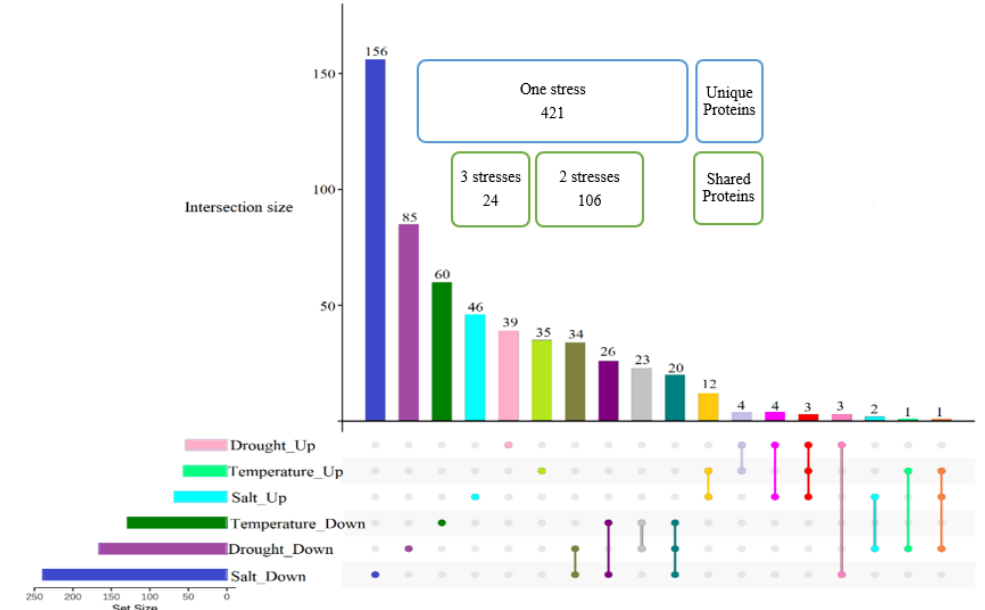
Figure 4. Number of proteins significantly differentially abundant uniquely and in common in response to salt, drought, and temperature. The Upset plot shows the proteins significantly differen- tially abundant under individual abiotic stresses, and shared with other stresses. The two highlighted groups show the number of proteins specific to each abiotic stress (unique proteins), and the number of proteins shared among abiotic stresses (shared proteins).